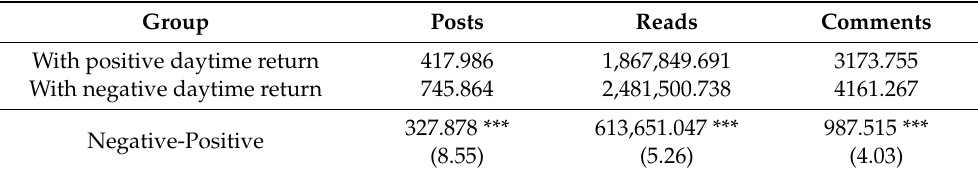
Table 6. Grouping of the Guba sample based on positive and negative daytime return. The table reports the average statistics of the Guba sample grouped according to trading days with positive returns and trading days with negative return, and a statistical test of their difference. Posts , Reads , and Comments are the average number of overnight posts, reads, and comments corresponding to a trading day, respectively. Group Posts Reads Comments With positive daytime return